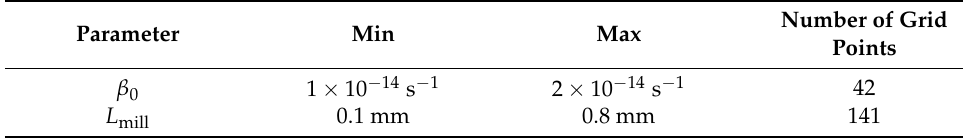
Table 1. Parameters for the numerical bifurcation analysis.